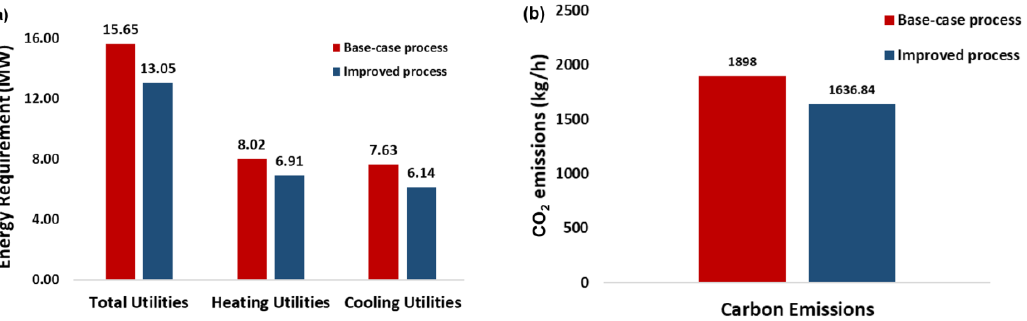
Figure 14. Comparison between the base-case and integrated processes of, ( a ) energy requirements, and ( b ) carbon emissions. and ( b ) carbon emissions.